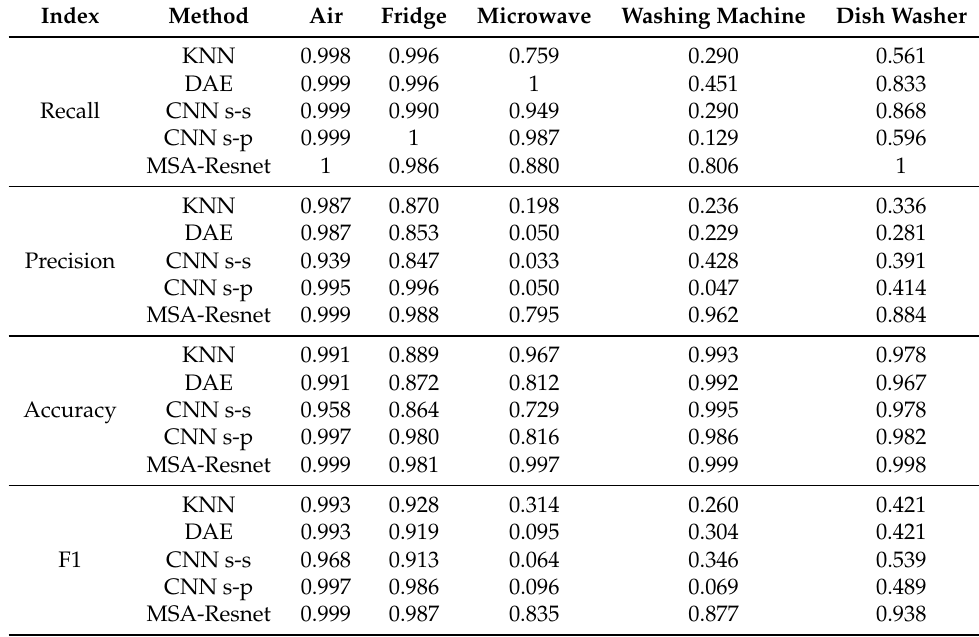
Table 2. Performance comparison of different algorithms for electrical on/off judgement of Household 25 in the WikiEnergy dataset.